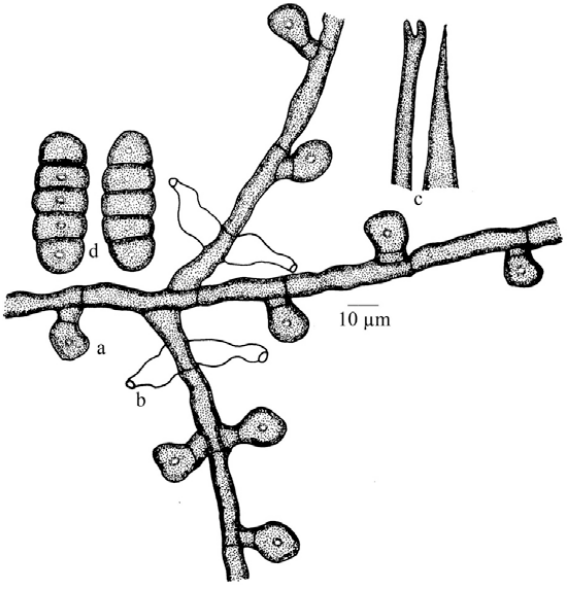
Figure 15. Meliola pithecellobii var. indica var. nov. a - Appressorium, b - Phialide, c - Apical portion of the mycelial setae; d -